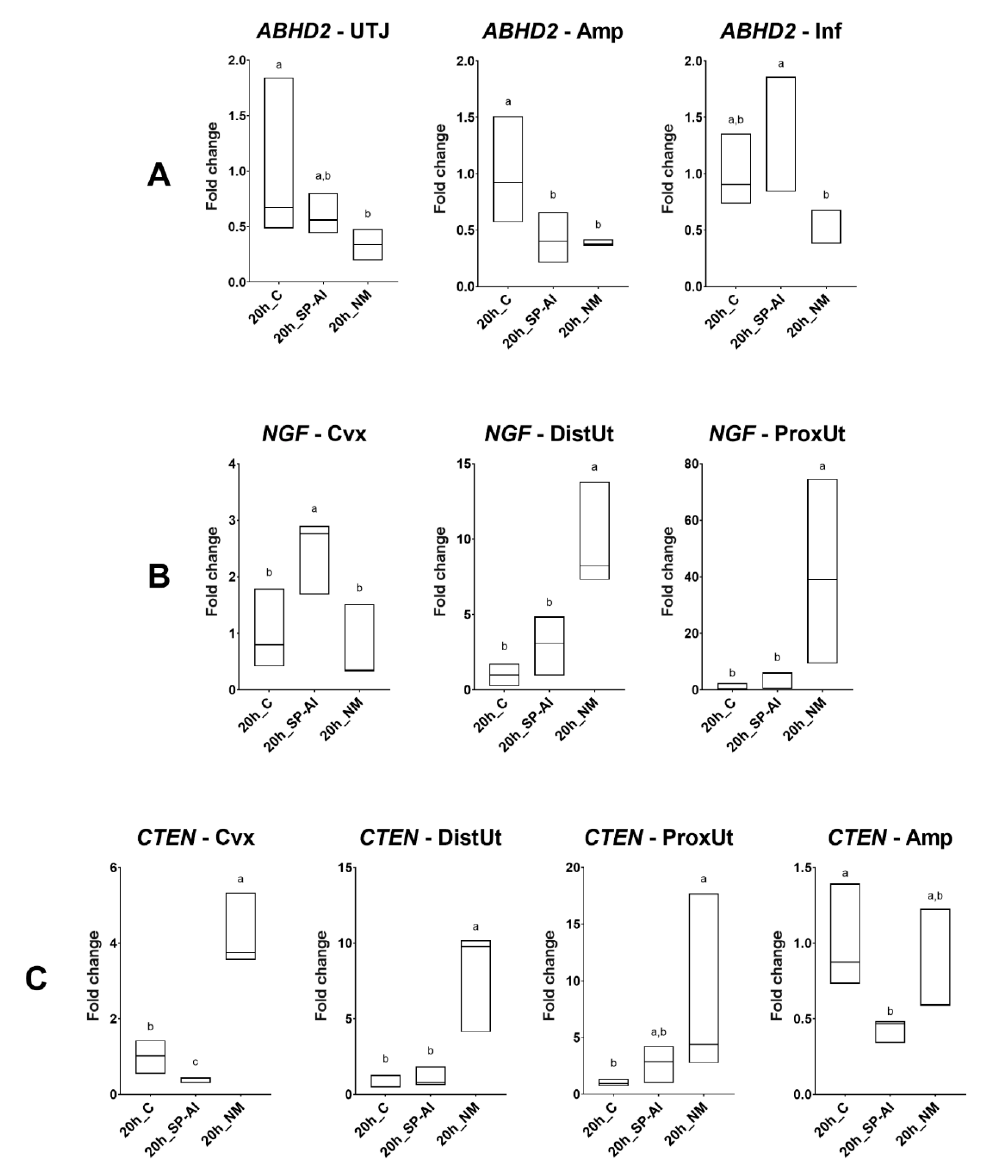
Figure 2. Results of Experiment 1. Gene expression of ( A ) ABHD2 , ( B ) NGF , and ( C ) CTEN